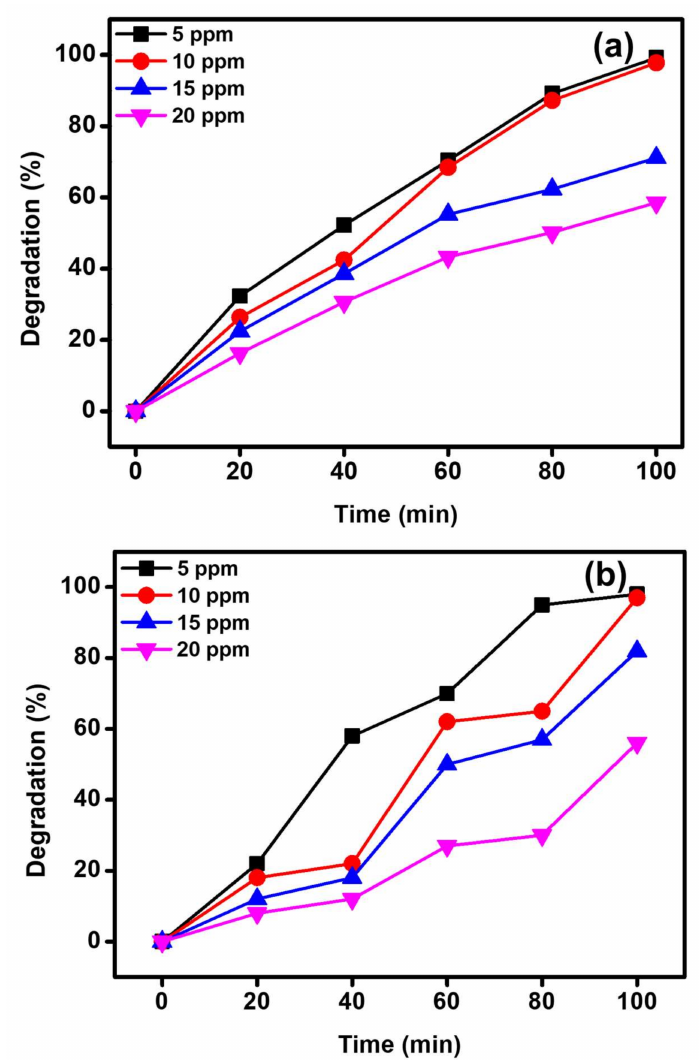
Figure 9. Impact of ( a ) MB and ( b ) MY concentration on the catalytic performance of the ZnO